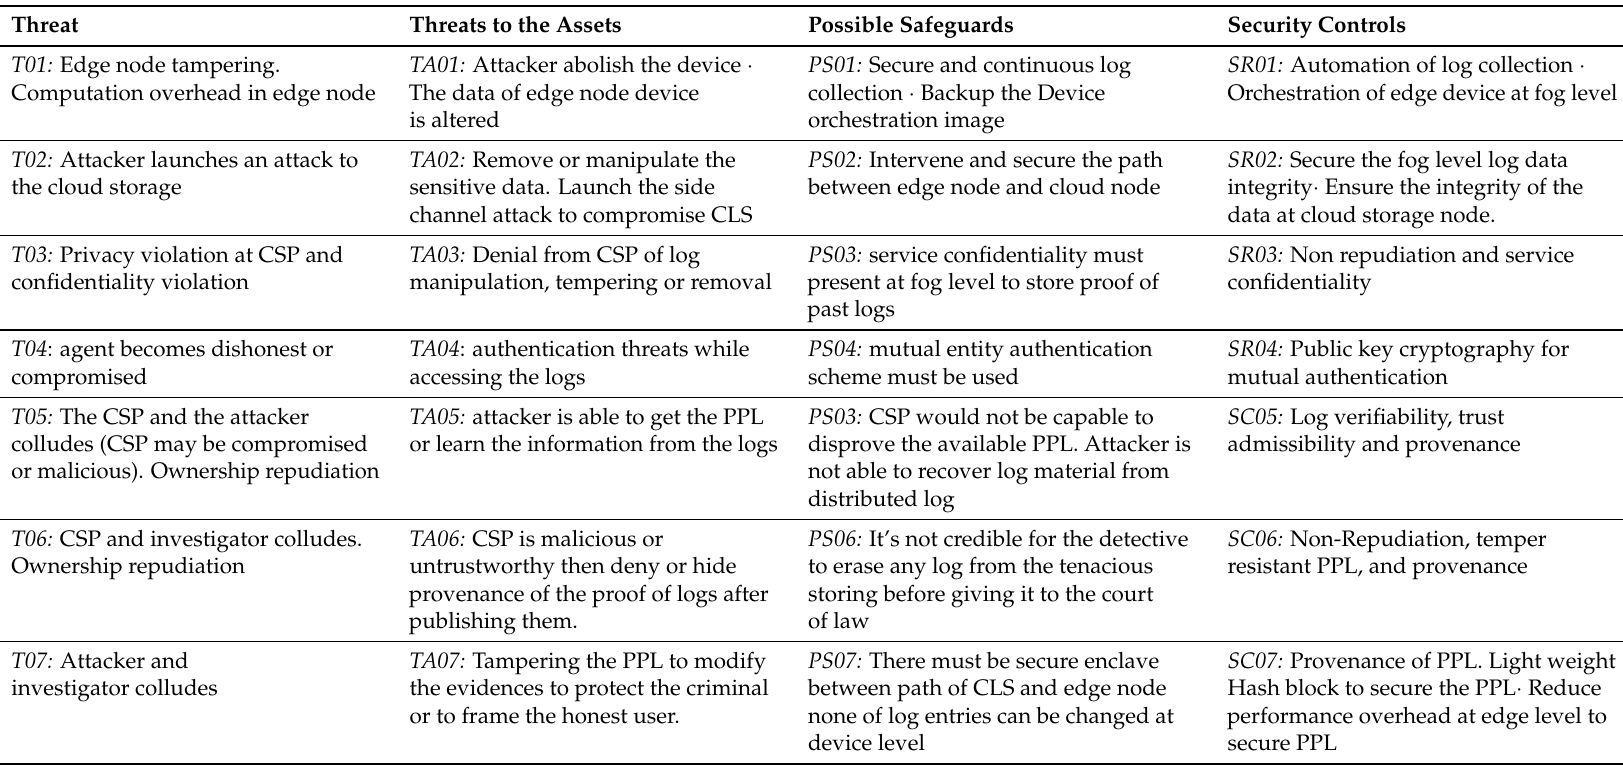
Table 2. Modelling attack